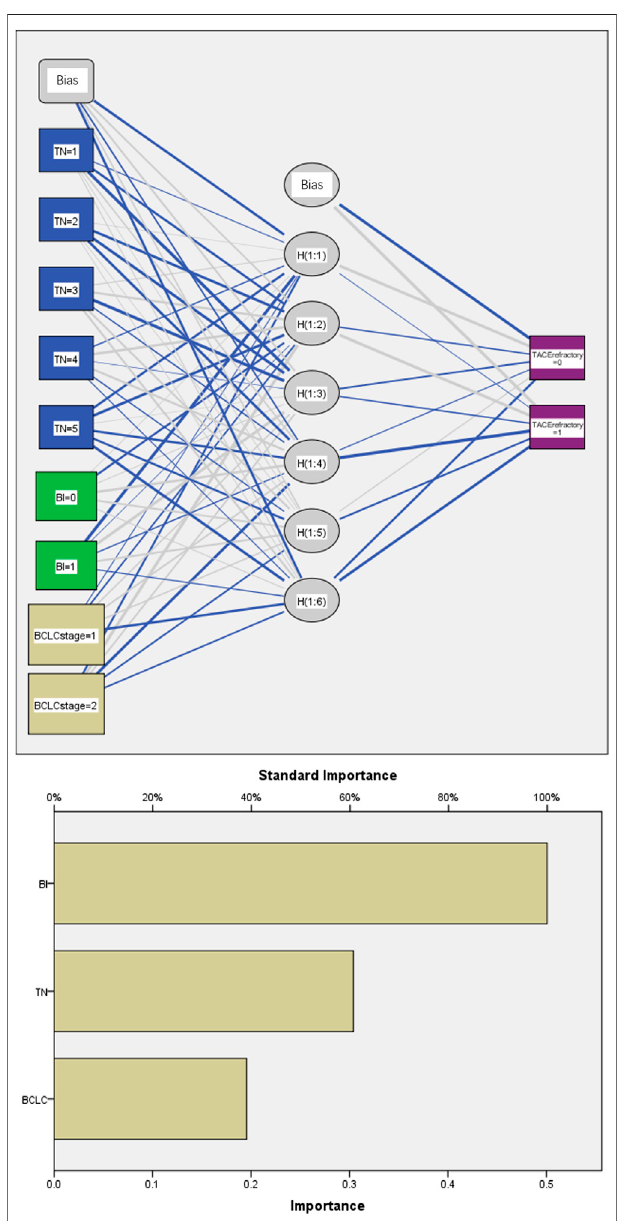
FIGURE 4 | Neural network analysis. BI: bilobular invasion; TN: tumor number. There were six nodes in the hidden layers. A total of 70% of samples were selected for training and the remaining 30% for